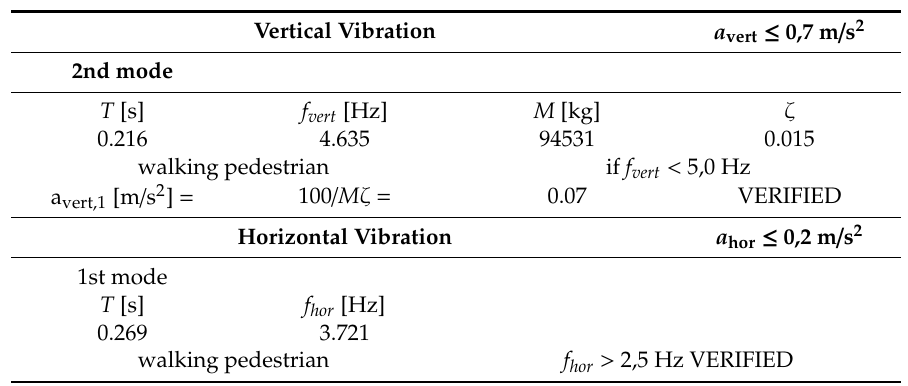
Table 5. Verification of comfort criteria ( T : period; f : frequency; M : total mass of the bridge; ξ : damping